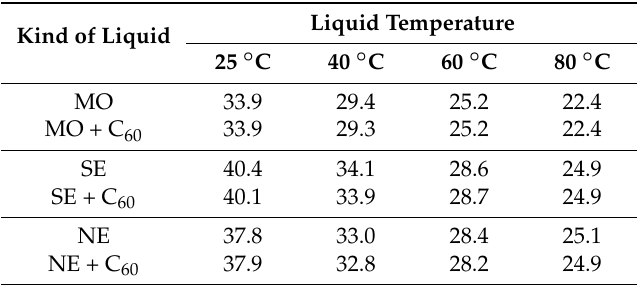
Table 5. Calculation results of the temperature decrease in pure electro-insulating liquids and nanofluids based on fullerene C